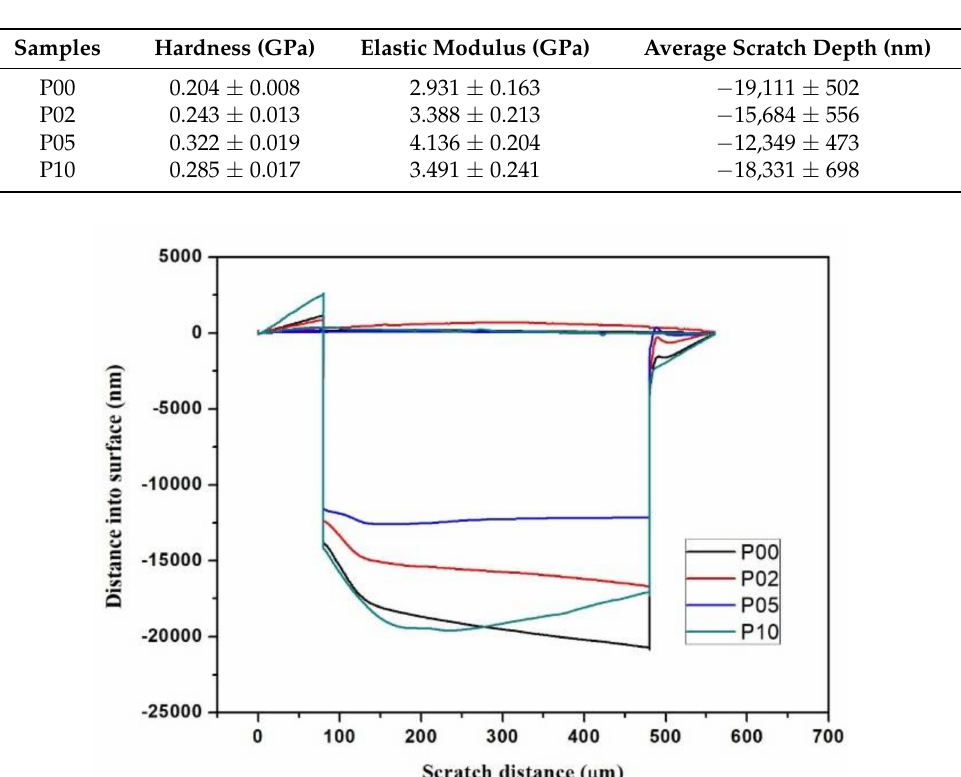
Figure 5. Influence of composite resins with different POSS additions on the scratch